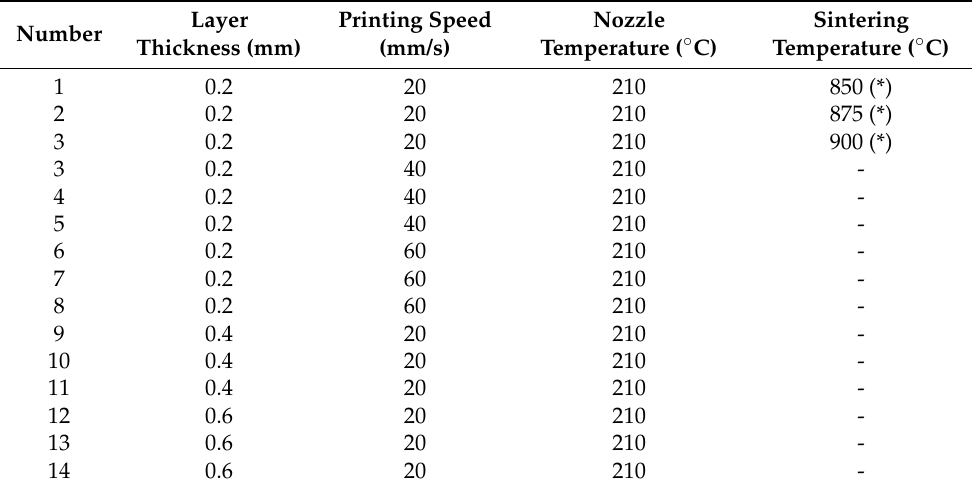
Figure 1. Schematic representation of pellet extruder. Table 1. The experimental program of